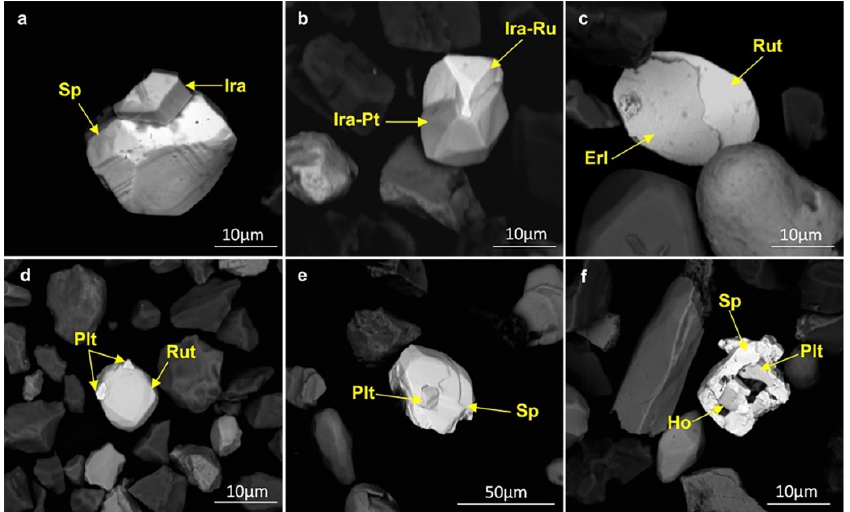
Figure 16. A selection of backscatter electron (BSE) images of platinum-group minerals (PGMs) forming polymineralic aggregates. Two-phase PGMs composed of ( a ) Sperrylite (Sp; PtAs 2 ) and irarsite (Ira; (Ir,Ru,Rh,Pt)AsS); ( b ) Pt-rich irarsite (Ira-Pt) and Ru-rich irarsite (Ira-Ru); ( c ) Rutheniridosmine (Rut; (Ir,Os,Ru)) and erlichmanite (Erl; OsS 2 ); ( d ) Rutheniridosmine and platarsite (Plt; (Pt,Rh,Ru)AsS); ( e ) Platarsite and sperrylite; and ( f ) A three-phase PGM composed of sperrylite, platarsite and hollingworthite (Ho; (Rh,Pt,Pd)AsS).